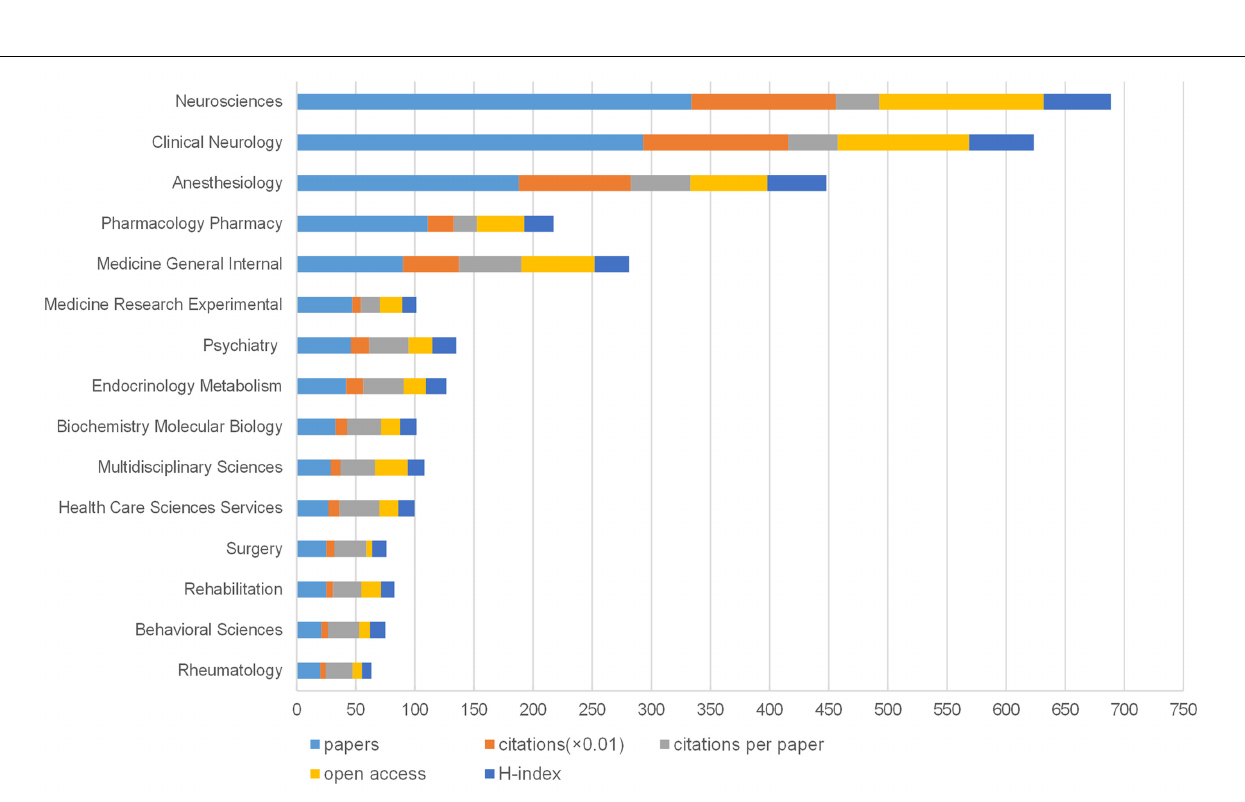
Frontiers in Human Neuroscience |